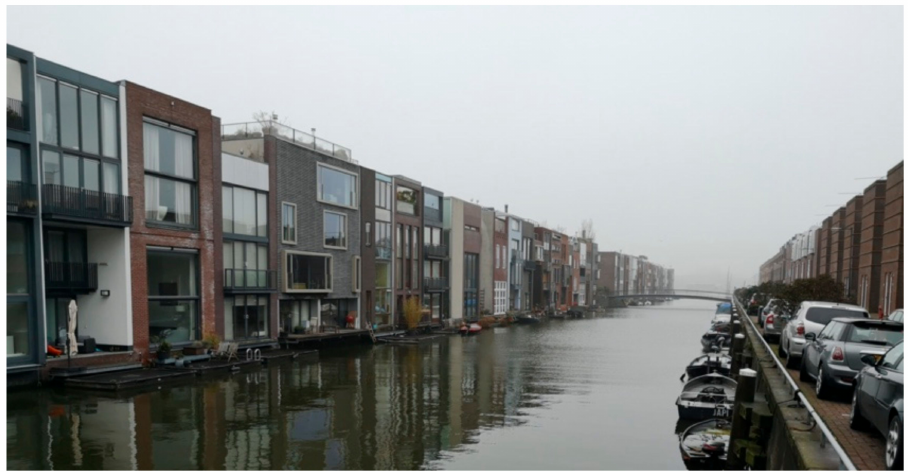
Figure 6. Photograph of case study 1: Borneo Island. Source: